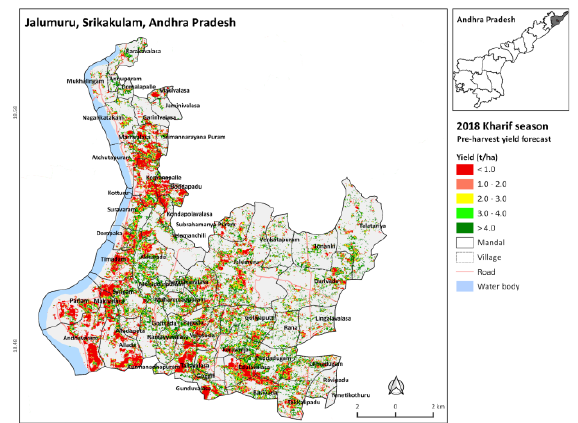
Figure 6. Pre-harvest yield forecast in Jalumuru mandal,